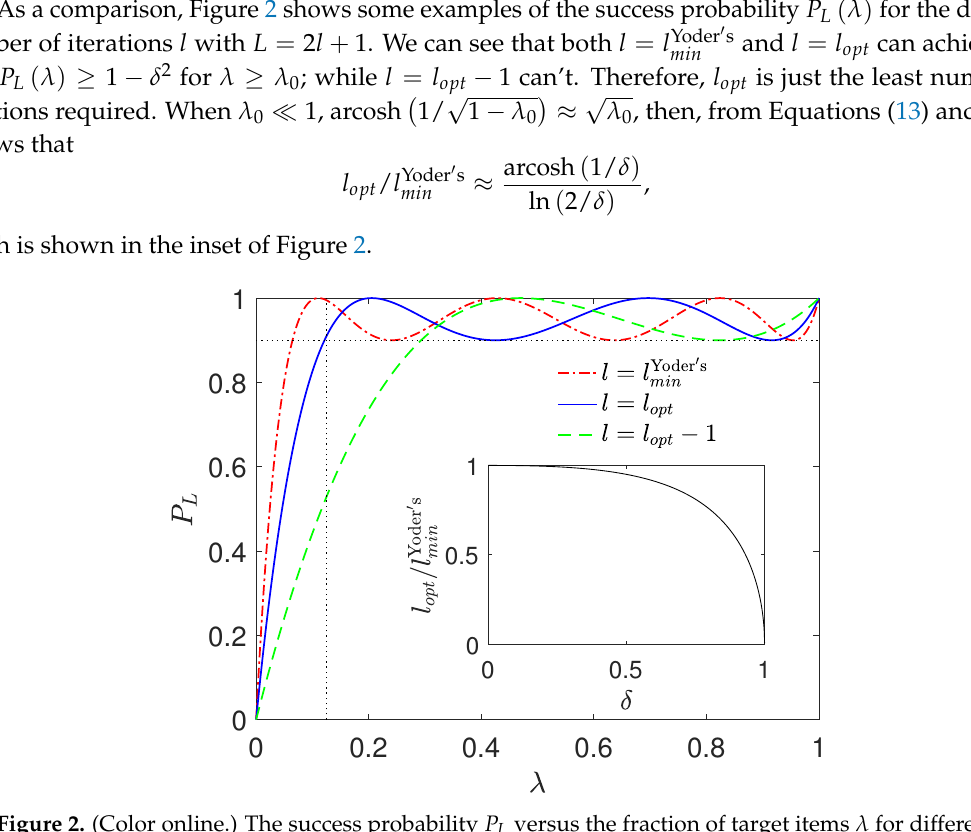
Figure 2. (Color online.) The success probability P L versus the fraction of target items λ for different number of iterations l with L = 2 l + 1, λ ≥ λ 0 = 0.125 (dotted vertical line) and P L ≥ 1 − δ 2 = 0.9 (dotted horizontal line). The red dashed-dotted, blue solid, and green dashed curves correspond to = 3, l = l opt = 2 and l = l opt − 1, respectively. Inset: We plot l opt / l Yoder (cid:48) s l = l Yoder (cid:48) s min λ 0 (cid:28)